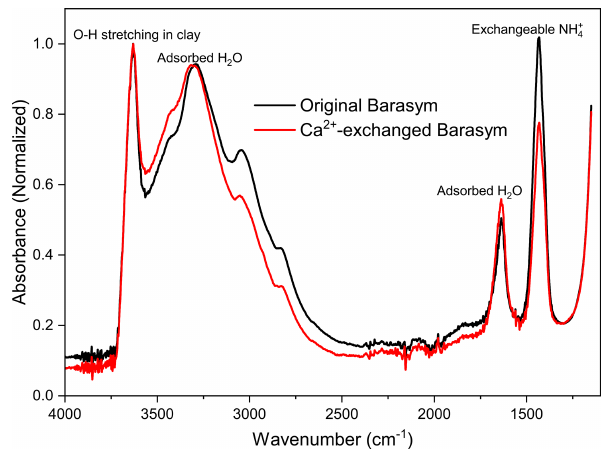
Figure B1. FTIR spectra for original and Ca 2 + -exchanged Barasym samples for semi-quantitative analysis of Ca 2 + exchange with NH + 4